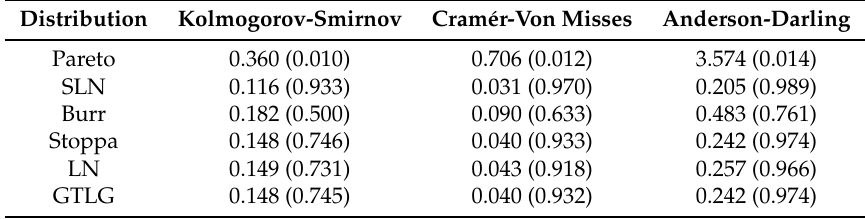
Table 2. Test statistics ( p -values) of goodness-of-fit tests of the considered models when α =